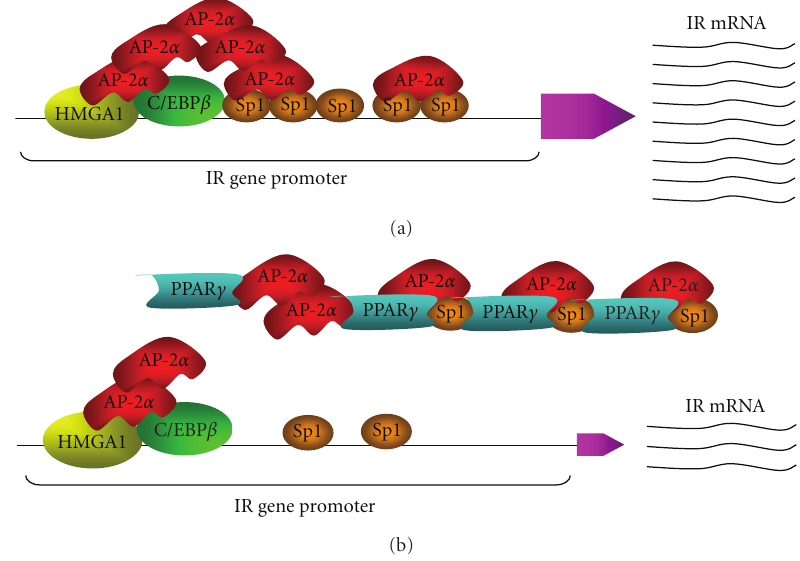
Figure 2: Proposed model for the action of PPAR γ in the context of the IR gene. AP-2 α overexpression accounts for increased IR expression in both breast cancer cell lines and breast cancer tissues [31]. In this model, interactions between AP-2 α and Sp1 in the preinitiation complex at the IR promoter are facilitated and stabilized by HMGA1. By binding to AP-2 α and Sp1, PPAR γ may attenuate the stimulatory role of AP-2 α in IR gene expression in breast